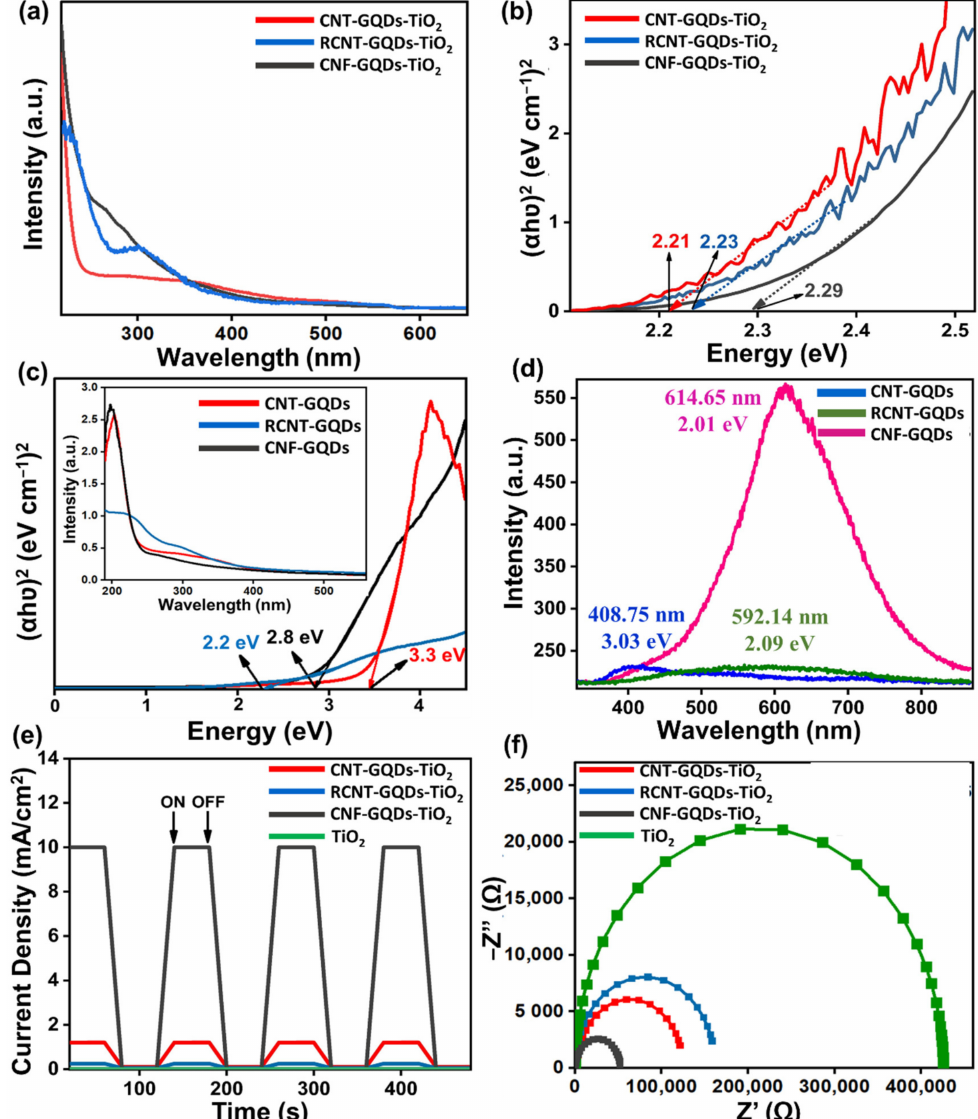
Figure 4. ( a ) UV-vis absorption of as-synthesized GQDs-TiO 2 nanocomposites, ( b ) Tauc plot of respective GQDs-TiO 2 nanocomposites, ( c ) Tauc plot of as-synthesized GQDs with respective UV-vis absorption as inset image, ( d ) Photoluminescence (PL) spectra of as-synthesized GQDs excited at 325 nm by He-Ne laser. Photoelectrochemical analysis ( e ) Transient photocurrent response of the as-prepared GQDs-TiO 2 nanocomposites, ( f ) EIS